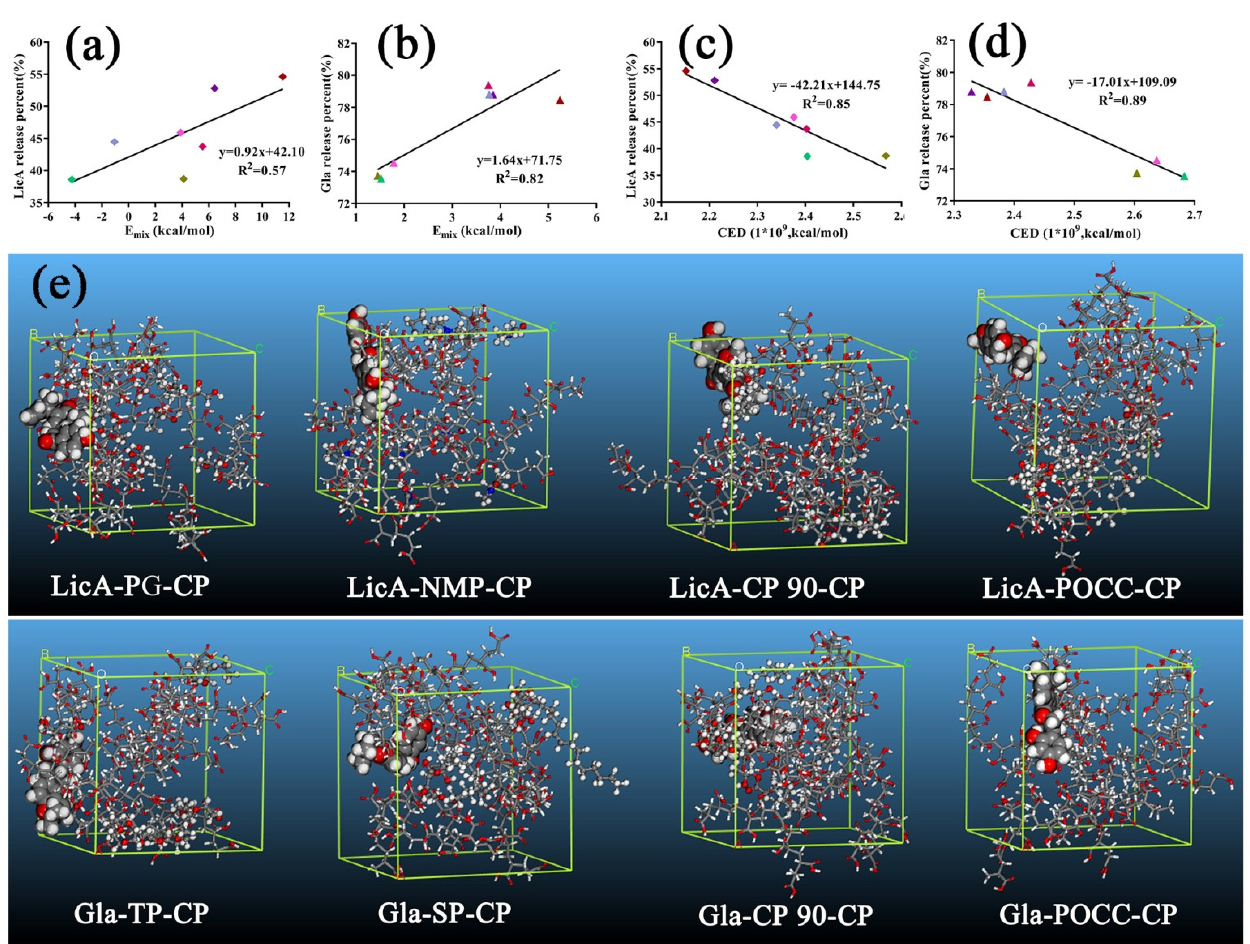
Figure 4. ( a ) The correlation relationship between the LicA release percent and E mix of ternary systems; ( b ) linear analysis of the Gla release percent and E mix of ternary systems; ( c ) the correlation relationship between the LicA release percent and CED of ternary systems; ( d ) linear analysis of the Gla release percent and CED of ternary systems; ( e ) snapshots of the LicA (Gla)–enhancers–CP systems at the end of the MD (drug: ball and stick model; enhancers: CPK model).